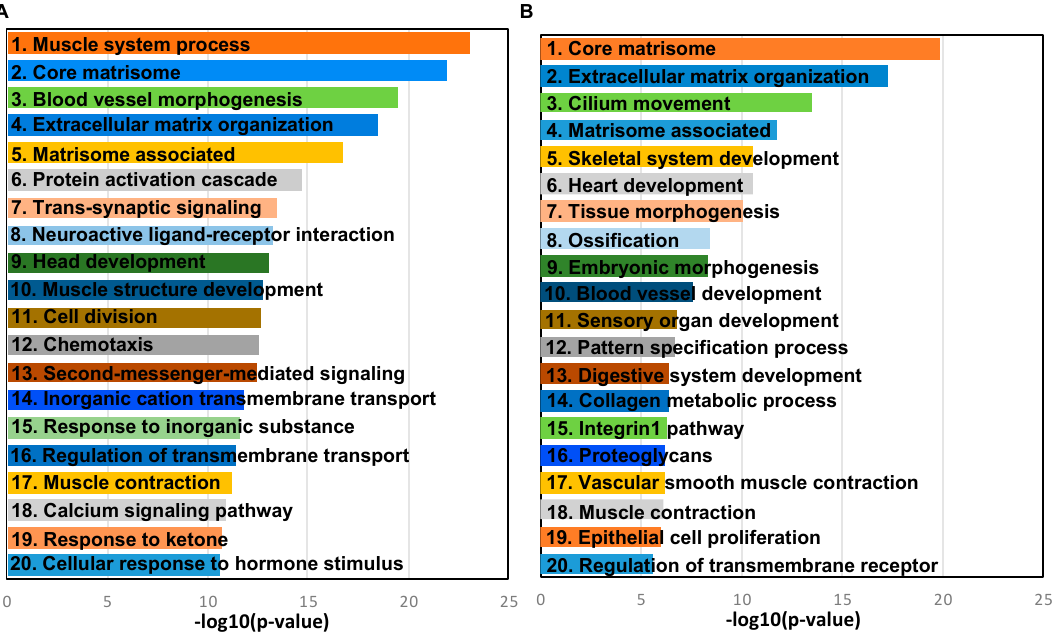
Figure 3. Deregulated pathways. ( A ) Most significantly deregulated pathways in primary tumors versus fallopian tube or ( B ) in metastasis versus primary tumors plotted against − log 10 ( p -values). 2.3. Overlapping Genes in Primary Tumors versus FT and Metastasis versus Primary